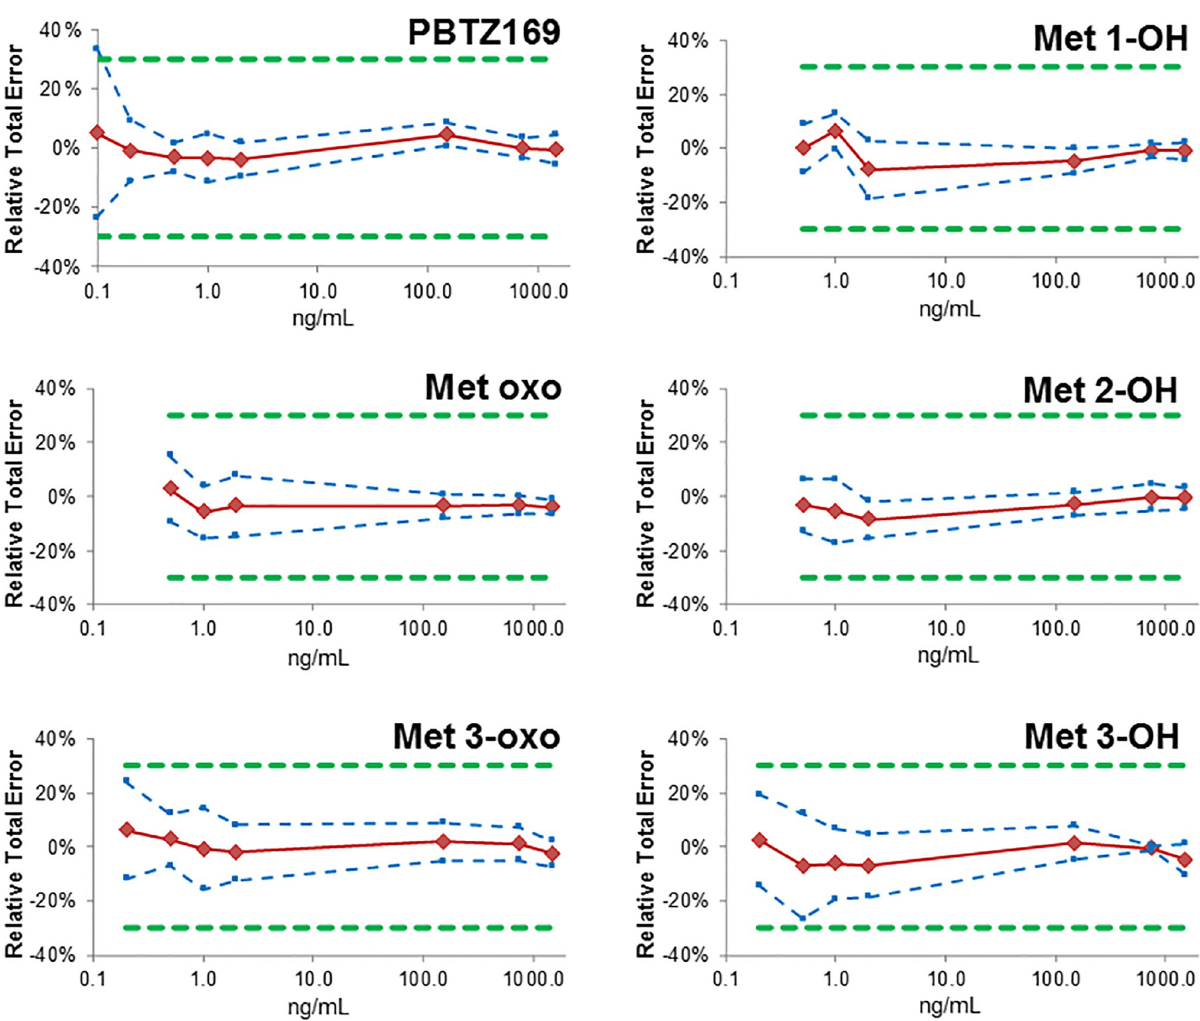
Fig 3. Accuracy profiles over the considered validation domain in plasma of PBTZ169 and its in vitro known active metabolites. Bias (red solid line), upper and lower β -expectation tolerance intervals ( β = 90%) (blue dotted lines) and acceptance limits ( λ = ± 30%), green dotted lines) are